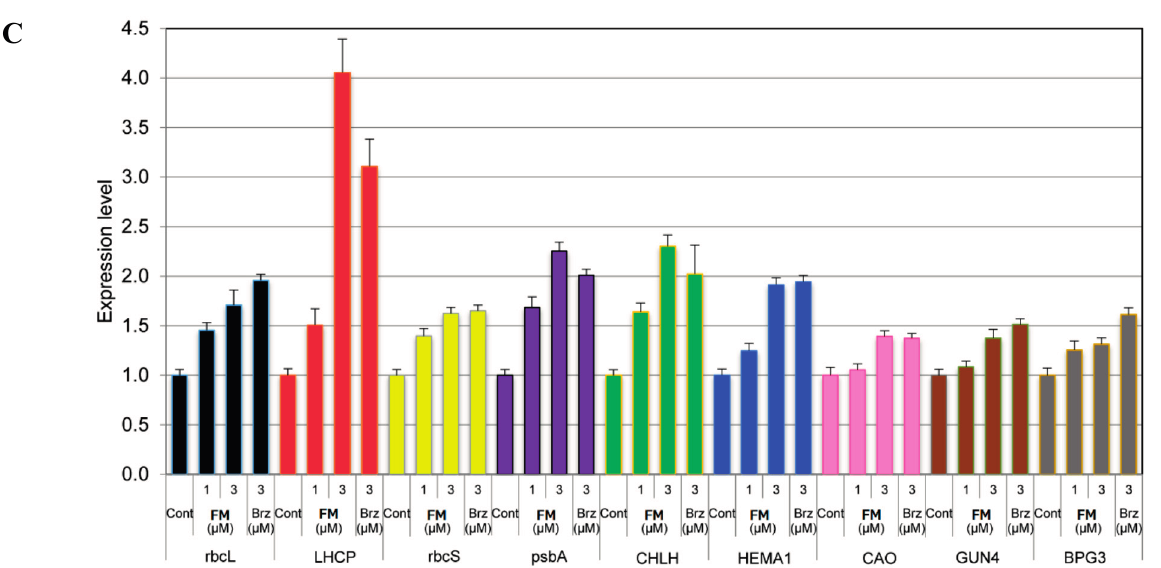
Figure 8. Quantitative RT-PCR experiment measuring the relative expression levels of BR-responsive genes: ( A ) Gene response to BR stimulation; ( B ) BR biosynthesis-related genes; and ( C ) photosynthesis-related genes. All results are means ± S.E., and all of